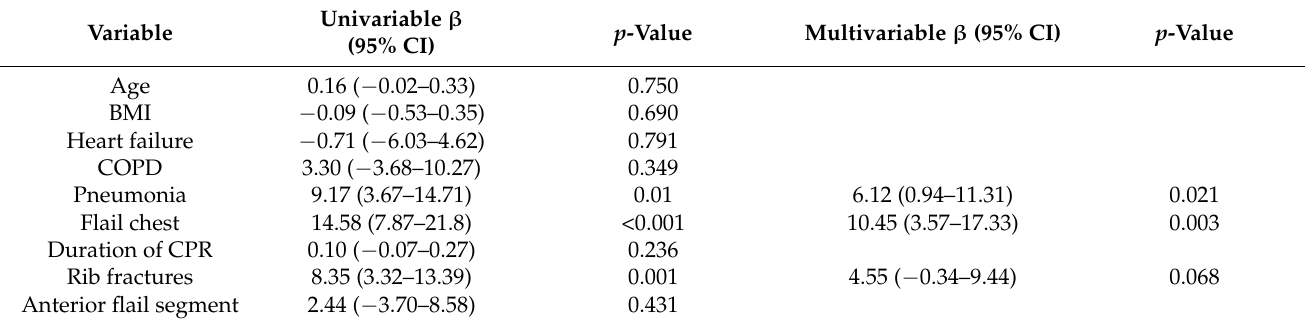
Table 6. Associations with mechanical ventilation in linear regression analysis.